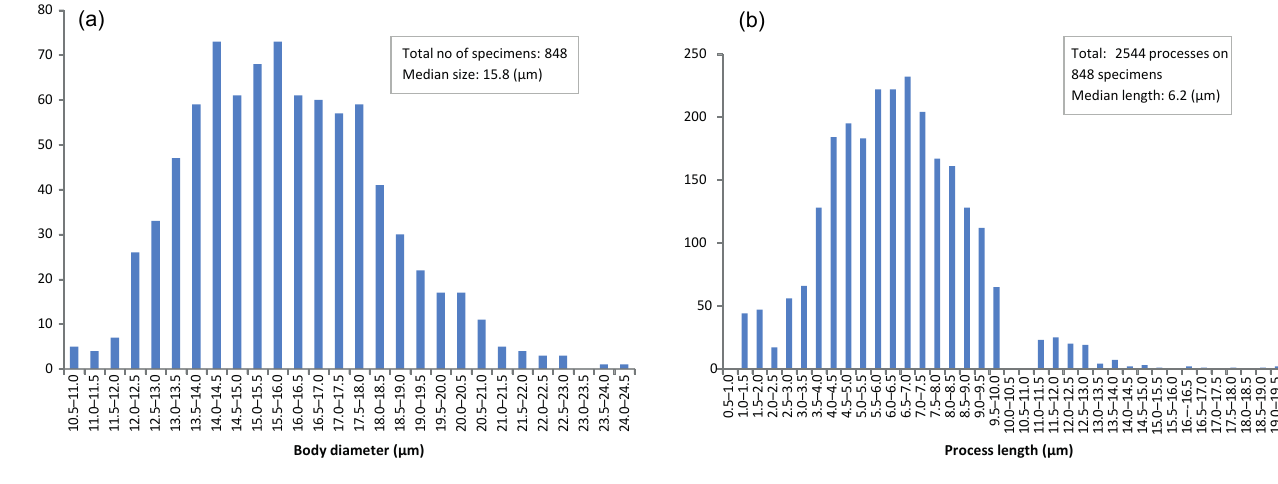
Figure 5. Size frequency of body diameter (a) and process length (b)